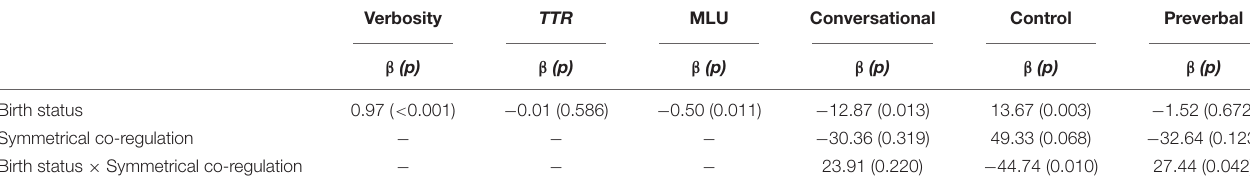
TABLE 5 | Multivariate analysis on IDS linguistic and pragmatic characteristics: Standardized estimated parameters of models 1 and 3, respectively. Verbosity TTR MLU Conversational